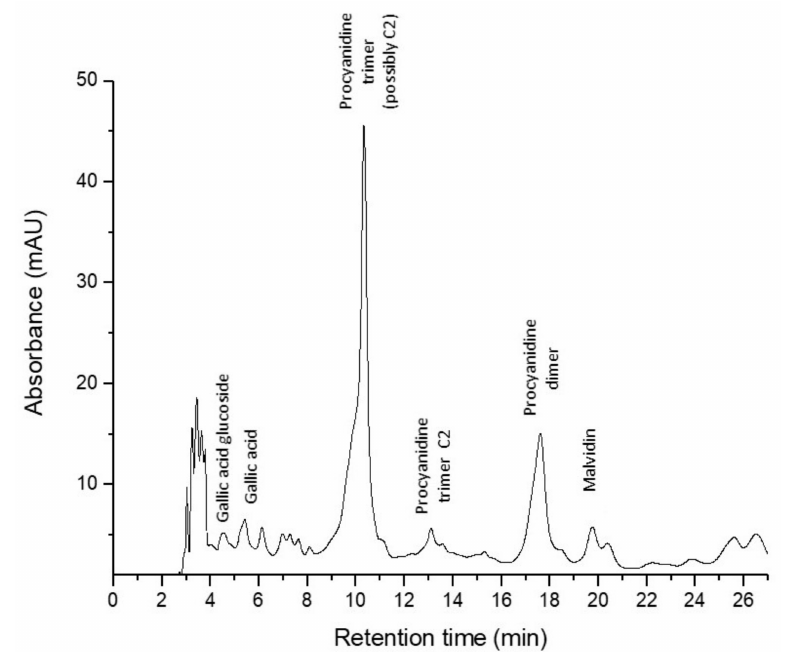
Figure 3. Grape pomace chromatogram.